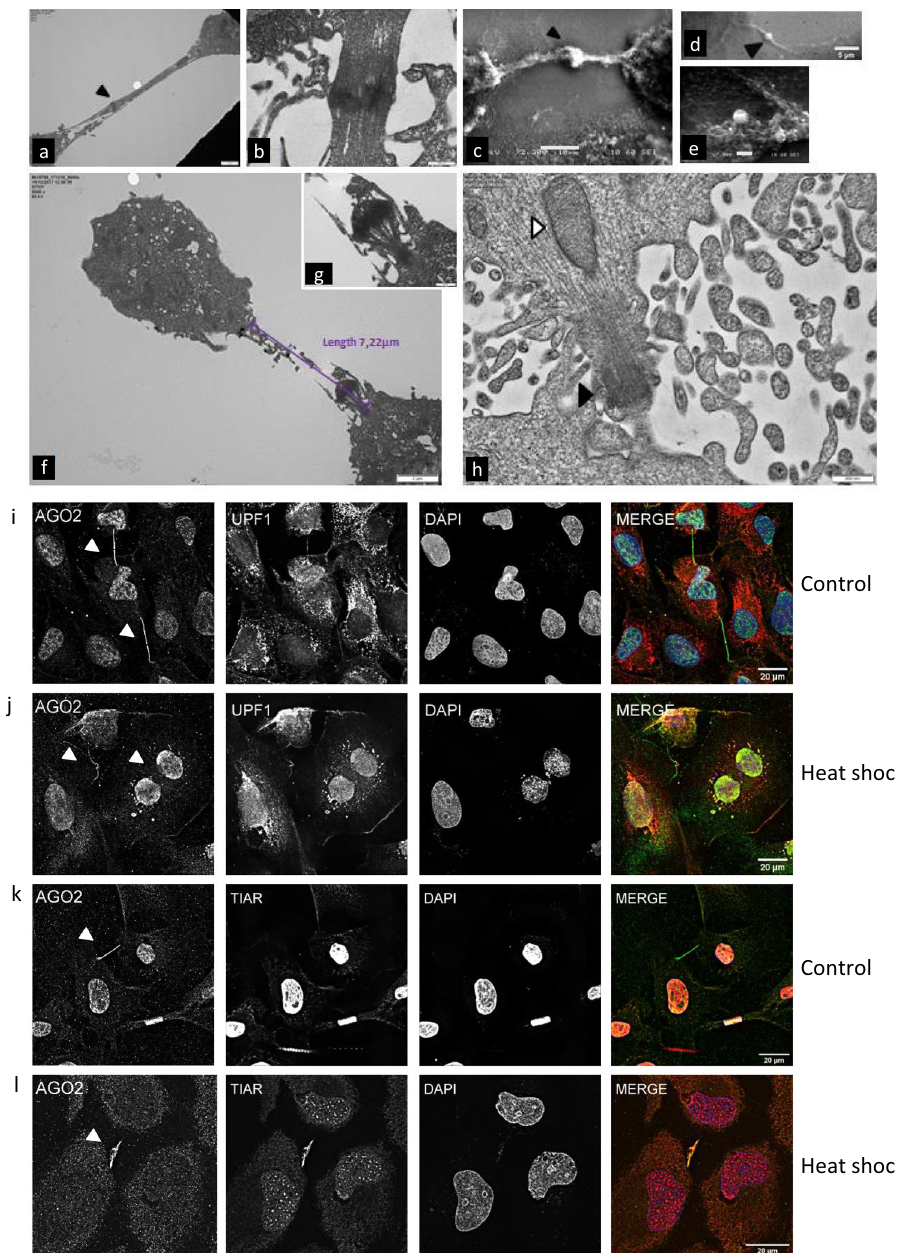
Fig. 9 Α GO2 is a stress-sensitive molecule. Electron microscopy images of the stages of cell division of NTHY ori 3-1 cells depicting the cytokinetic structures up to abscission. a , b , f – h Section transmission electron micrographs and c – e scanning electron micrographs of dividing cells. a Dense bundled microtubules (black arrowhead) in the midzone and b a magni fi ed midzone. c , d The midbody core and the electron-dense material ( fl emming body) concentrated at the midzone. e Cargoes are transferred through the microtubule protrusions. f , g A discontinued intercellular bridge between two daughter cells after abscission. The nucleus of the left-hand cell is visible. g A magni fi ed abscission point. h The characteristic structural architecture of microtubular axoneme after the completion of abscission (black arrowhead). Membrane deposition is pictured by the black arrowhead. Scale bars: a 2 μ m, b 500 nm, c 10 μ m, d 5 μ m, e 2 μ m, f 2 μ m, g 500 nm, and h 500 nm. i – l Representative images of NTHY ori 3-1 cells before and after heat shock. AGO2, Upf1, and TIAR subcellular distribution in i , k control and j , l heat-shocked cells. AGO2 is represented in green, Upf1, TIAR in red, and nuclei in DAPI (blue). The white arrowheads indicate cytokinetic events (scale bar: 20 μ